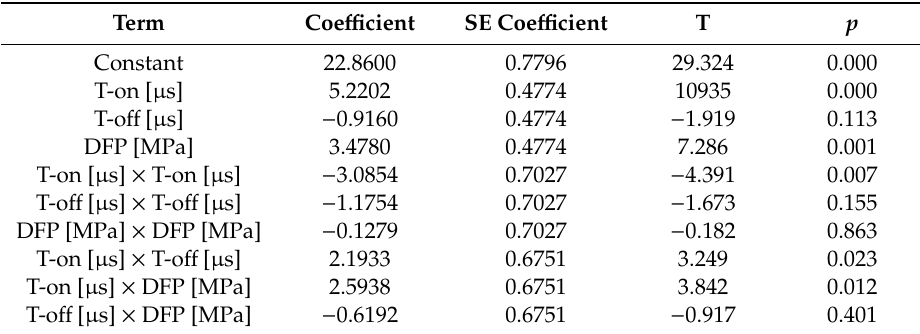
Table 5. Estimated regression coe ffi cients and summary statistics of adopted response surface full quadratic model for